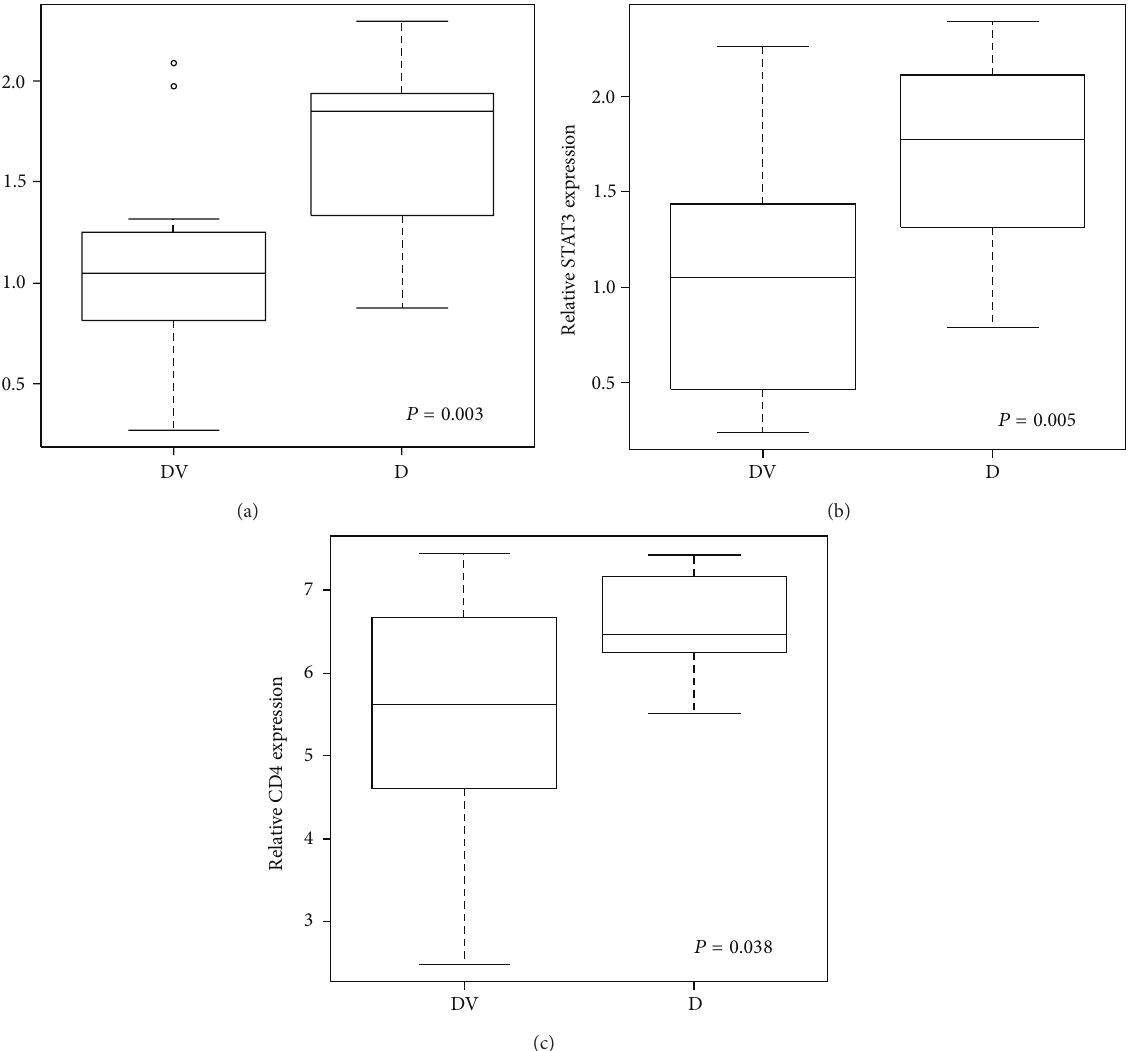
Figure 1: Verification of gene microarray data. Relative expression of TGF beta1, STAT3, and CD4 by qRT-PCR (data were obtained from an independent cohort of 14 newly diagnosed patients with T1D and 12 healthy